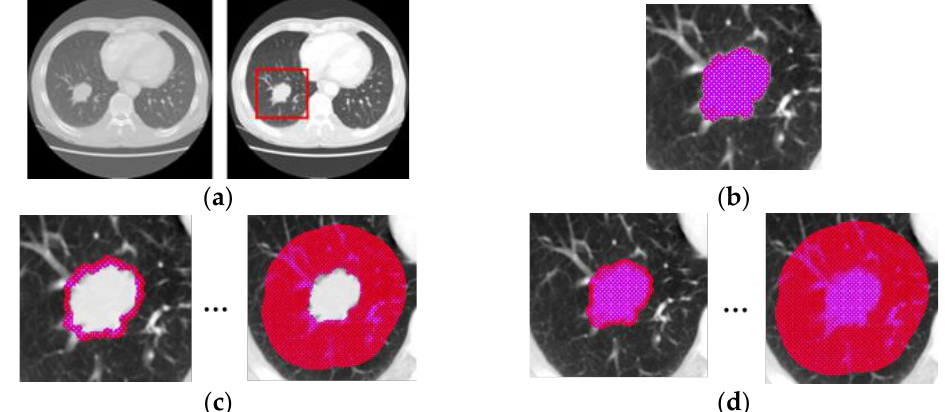
Figure 4. Illustration of data preparation. ( a ) Preprocessing and ( b – d ) region definitions for CT im- ages.